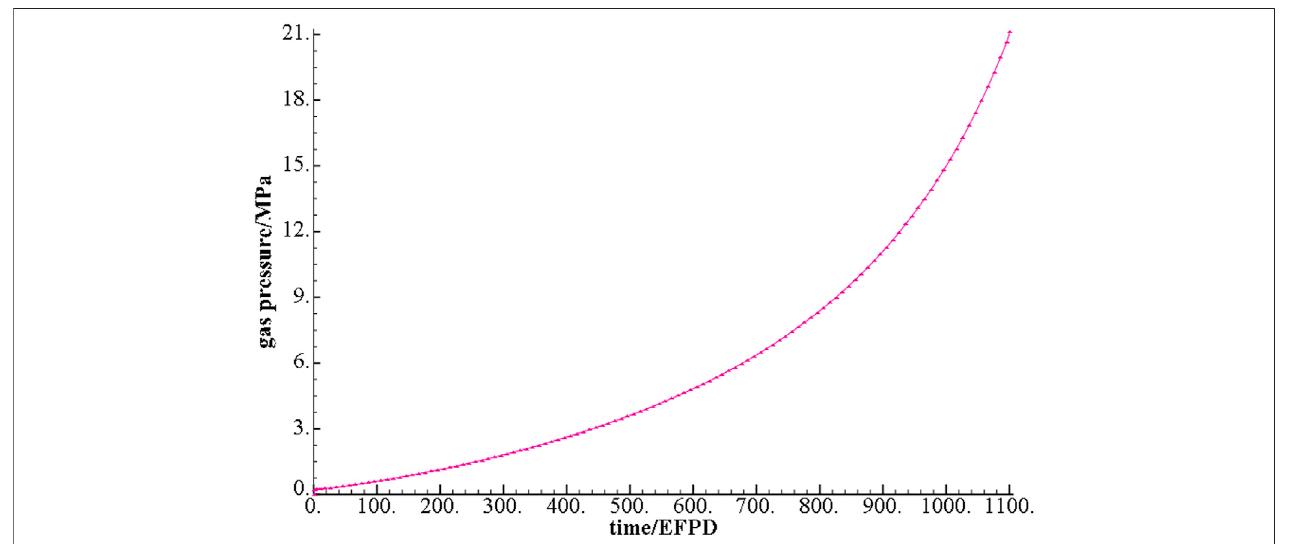
FIGURE 13 | Gap pressure variation with EFPD under steady operation